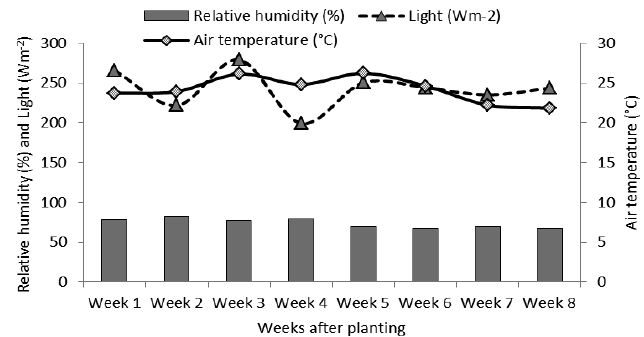
Fig. 1: Microclimate condition during greenhouse production of African nightshade